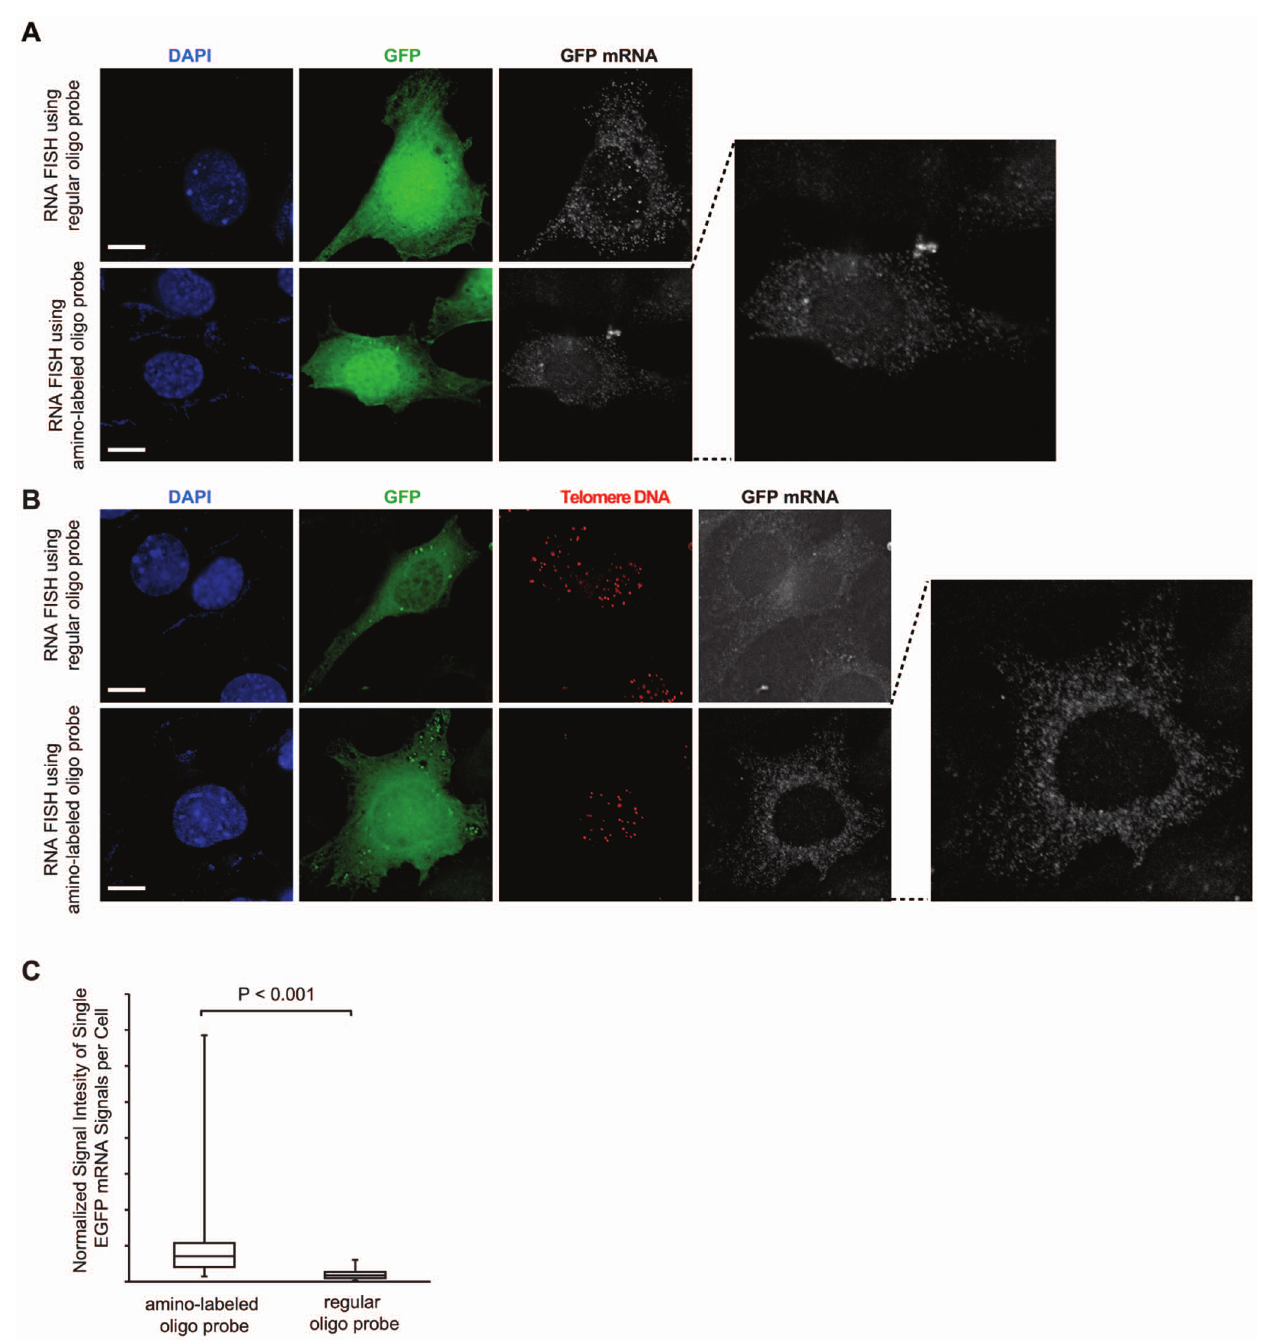
Figure 4. RNA-DNA FISH of the single mRNA molecules of EGFP and the telomeres (DNA). Telomere DNA was detected by Cy3-labeled oligonucleotide probes (shown in red). Nuclei were stained by DAPI (blue). The cells used were mouse fibroblast cells transiently transfected by an EGFP-expressing plasmid. The single mRNA molecules of EGFP were detected by a set of 20 oligonucleotides labeled by Cy5 (shown in grey). Two enlarged images of the single molecule RNA signals are shown on the right side. The images of the single molecule RNA signals are deconvolved single-layer z-sections. A scale bar of 10 m m is shown in each Dapi image. (A) RNA FISH only. (B) RNA-DNA FISH. (C) The total fluorescent signal intensity of the EGFP single mRNA molecule signals per cell (n=50) measured from the Cy5 channel was normalized by the total EGFP fluorescent intensity per cell measured from the ‘‘green’’ channel. The data was presented in box-and-whisker plots. The P-value was calculated using Student t- test.